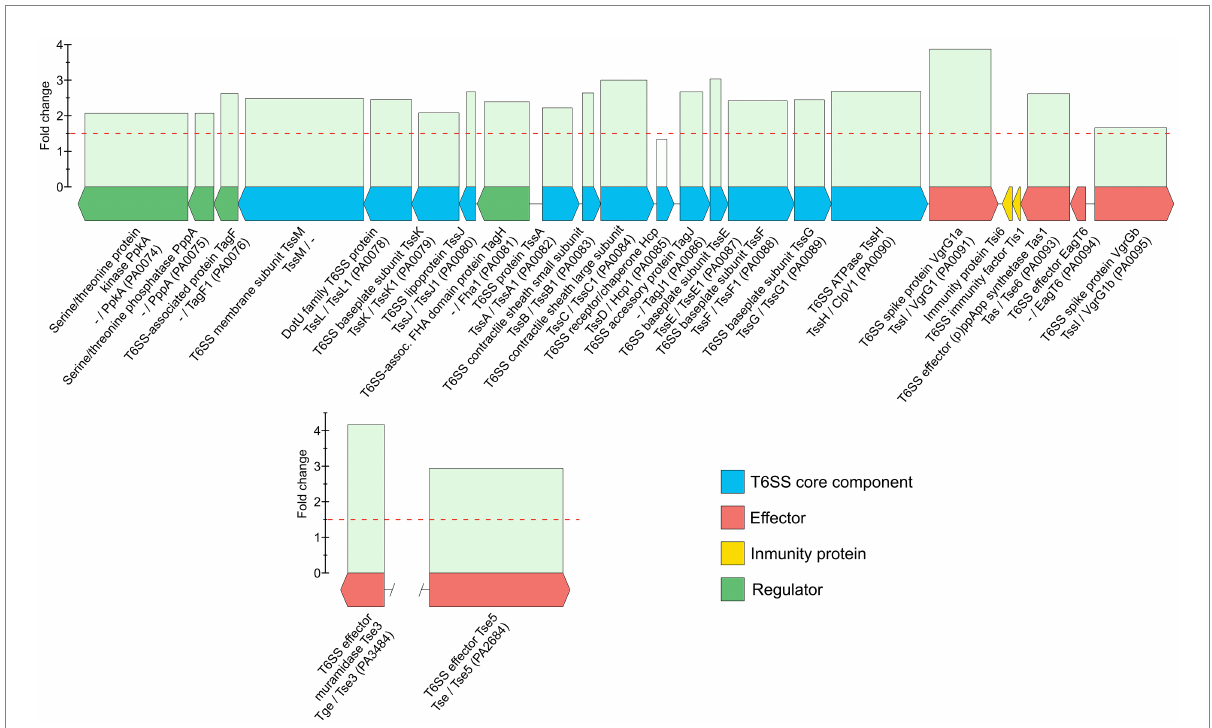
FIGURE 3 Genetic map of the H1-T6SS of Pseudomonas aeruginosa CCUG 51971 and relative abundances of its protein products at 256 μ g/ml (½ MIC) compared to 0 μ g/ml. Annotations from RefSeq, SecReT6 and Pseudomonas Genome Database are indicated, if